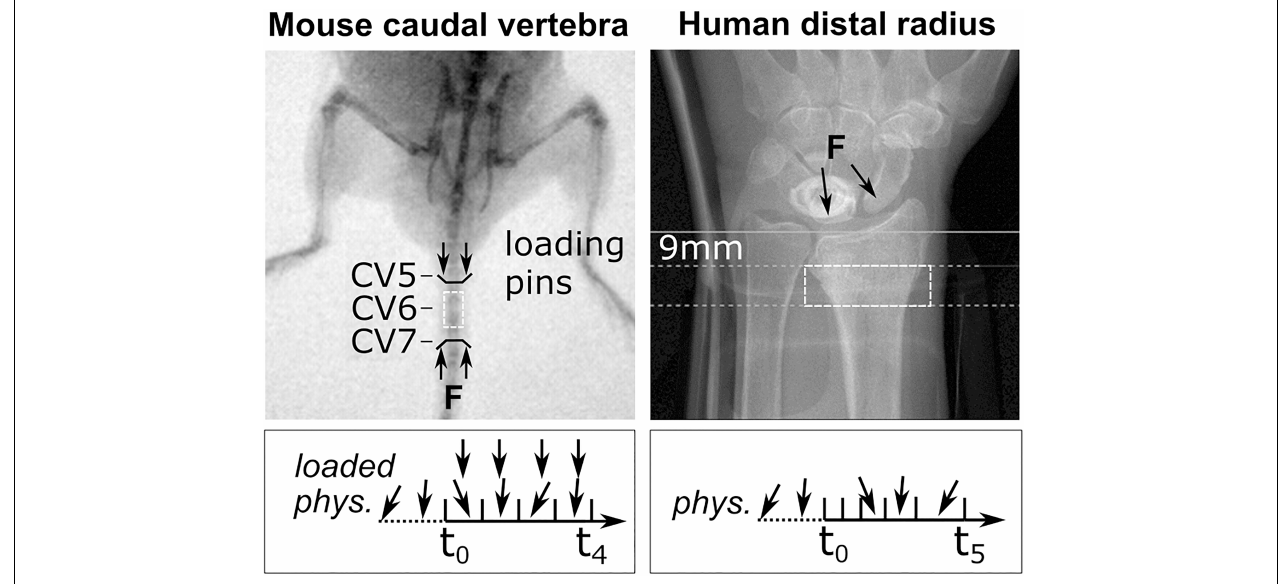
FIGURE 1 | Representative fluoroscopic images of in vivo scanning sites. The C6 mouse caudal vertebra (dashed box, left) was scanned by micro-CT. Black lines indicate sites of loading pins in the C5 (clamped) and C7 (loaded) vertebra. A representative loading scenario is indicated below for physiologically loaded (phys.) and extra-physiologically loaded (loaded) groups throughout the study (t 0 –t 4 ). The human distal radius (dashed box, right) was scanned using high-resolution peripheral quantitative computed tomography (HR-pQCT; Xtreme CT II). Annotations indicate the manufacturer’s recommended scanning site, 9 mm proximal to the reference line, and the arrows represent the line of action of the joint forces on the radius as a result of physiological loading. The box below indicates representative loading throughout appointments t 0 –t 5